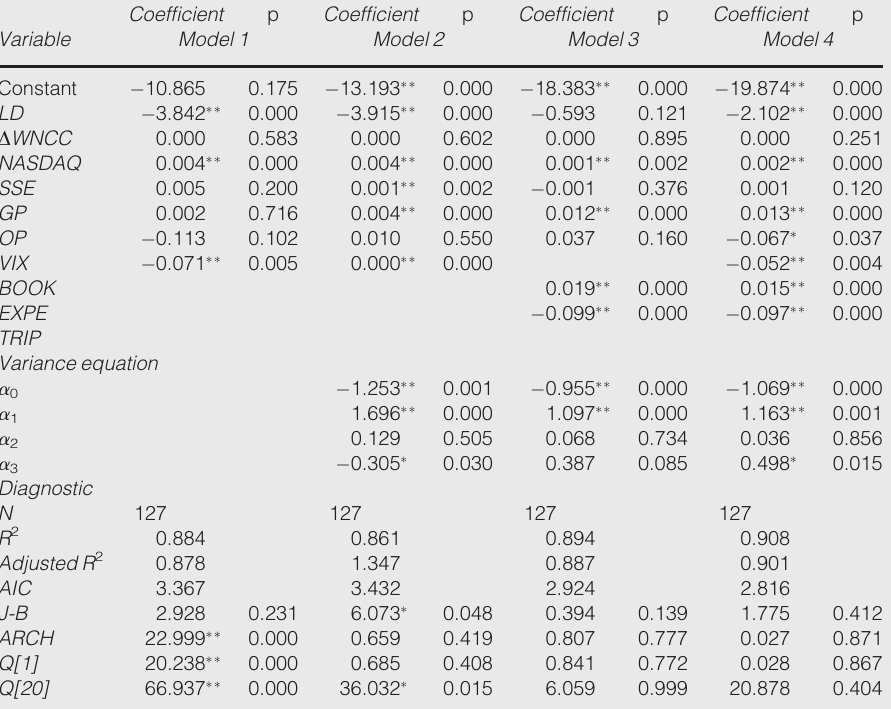
Table 5 Regression results for Trip.com Group Ltd.